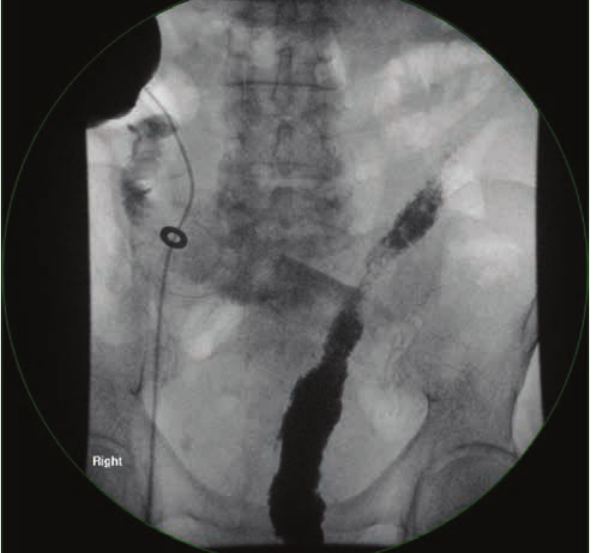
Figure 1: (Case 1) Routine Distal loopogram done 10 days post ULAR showing no evidence of contrast leak. Patient was discharged home well after the procedure.